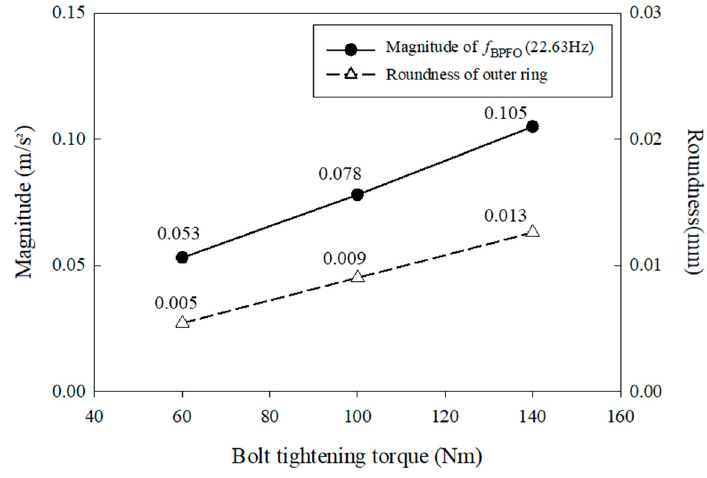
Figure 15. Variation in the vibration magnitude and the roundness of outer ring with respect to the bolt tightening torque.